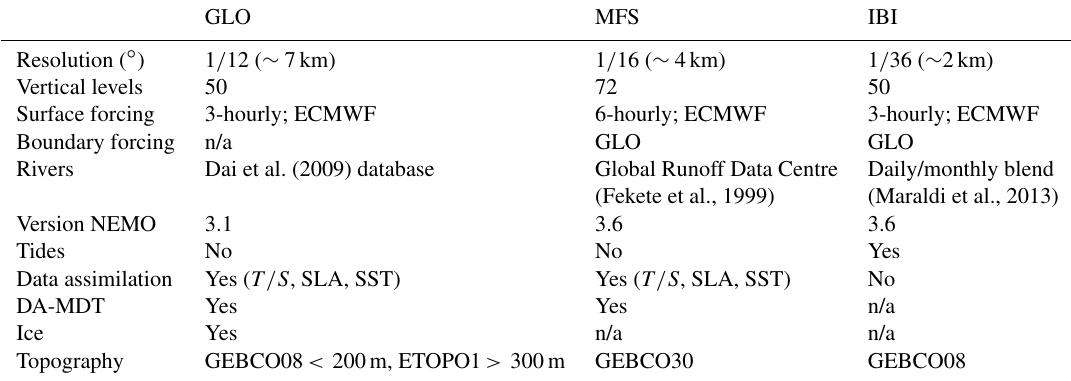
Table 1. Main characteristics of the three CMEMS models. Model resolutions are given in degrees; equivalents in kilometers for the Mediter- ranean are included in parentheses). DA-MDT indicates data assimilation of mean dynamic